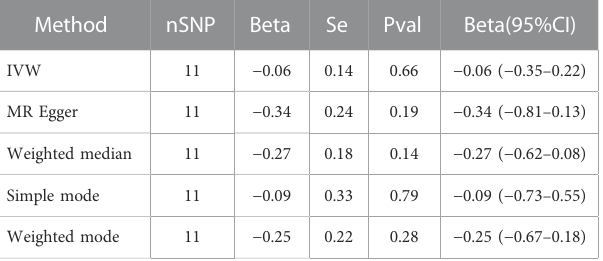
TABLE 1 Mendelian randomization outcomes between the vulnerability of COVID-19 and cardiac injury.